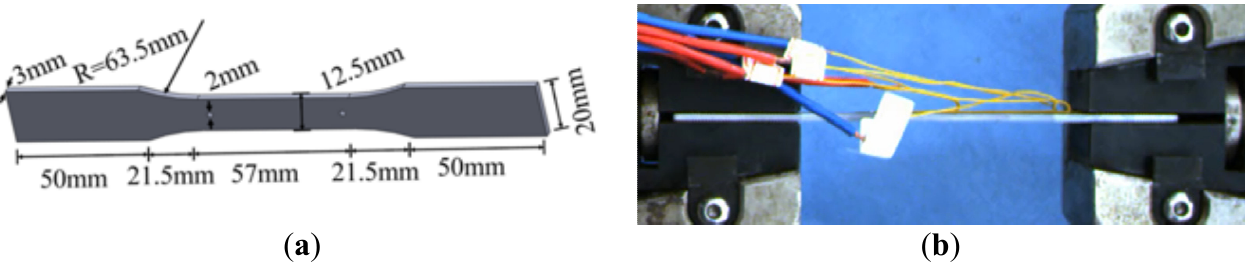
Figure 2. Specimen size and loading: ( a ) specimen size; ( b ) loading process.